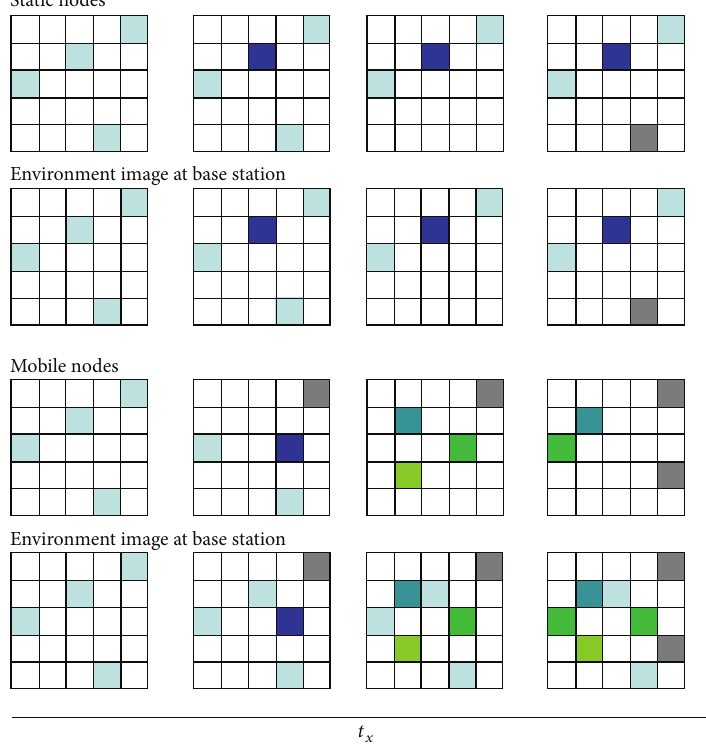
Figure 3: PREMON using static and mobile